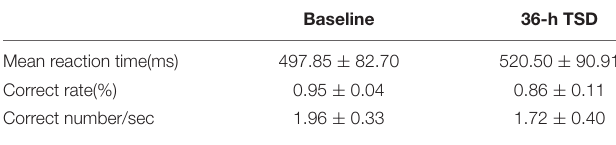
TABLE 1 | Behavioral data (mean ± SD) on the 2-back task at baseline and after 36-h